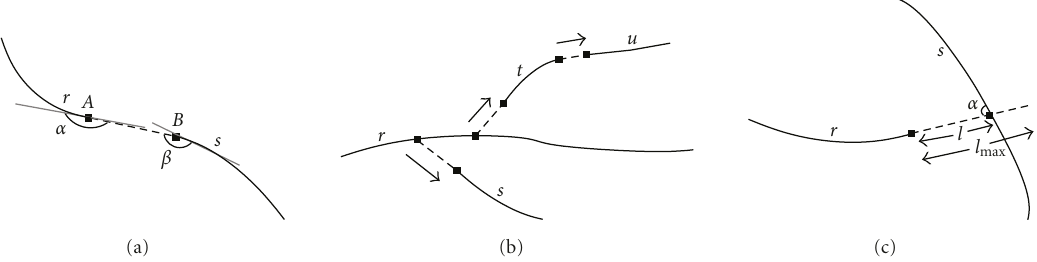
Figure 6: (a) Union of creases segments r and s . The angles between the new segment AB and the creases segments r ( α ) and s ( β ) are near π rad. so they are above the required threshold ((3 / 4) π ) and the union is finally accepted. (b) Retinal Vessel Tree reconstruction by unions ( t , u ) and bifurcations ( r , s ) and ( r , t ). (c) Bifurcation between segment r and s . The endpoint of r is prolonged a maximum distance l max and eventually a point of segment s is found.